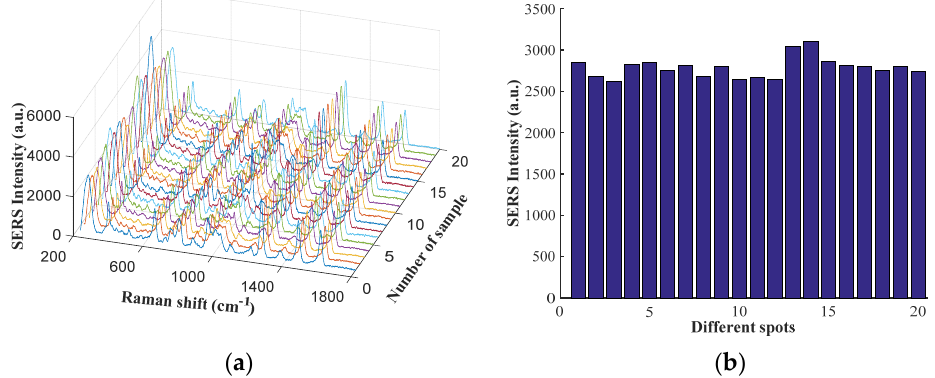
Figure 6. ( a ) SERS spectra of pork containing clenbuterol (10 µ g/g); ( b ) SERS intensities of clenbuterol in pork at 1259 cm − 1 .